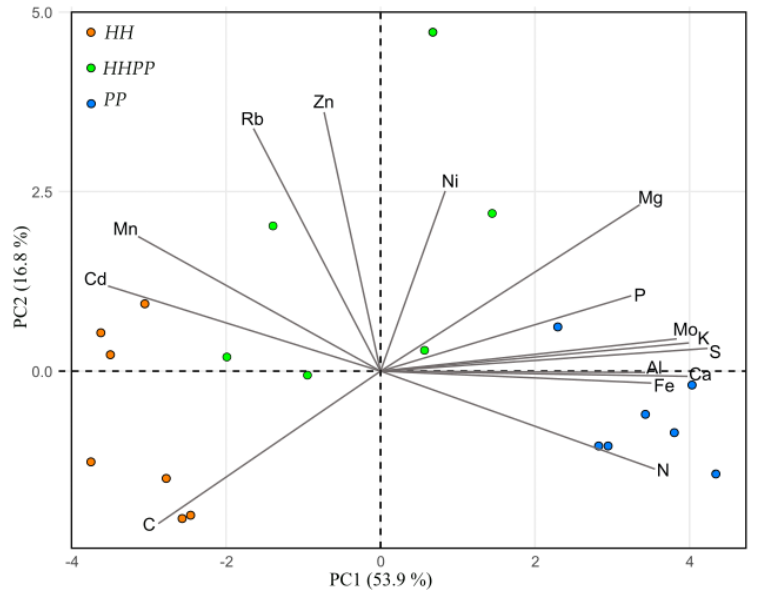
Figure 4. Principal component analysis (PCA) biplot of the foliar elemental contents (variables) in the individuals (samples) of the three Oeosporangium species. PC = principal component. n = 6−7 individuals per species.